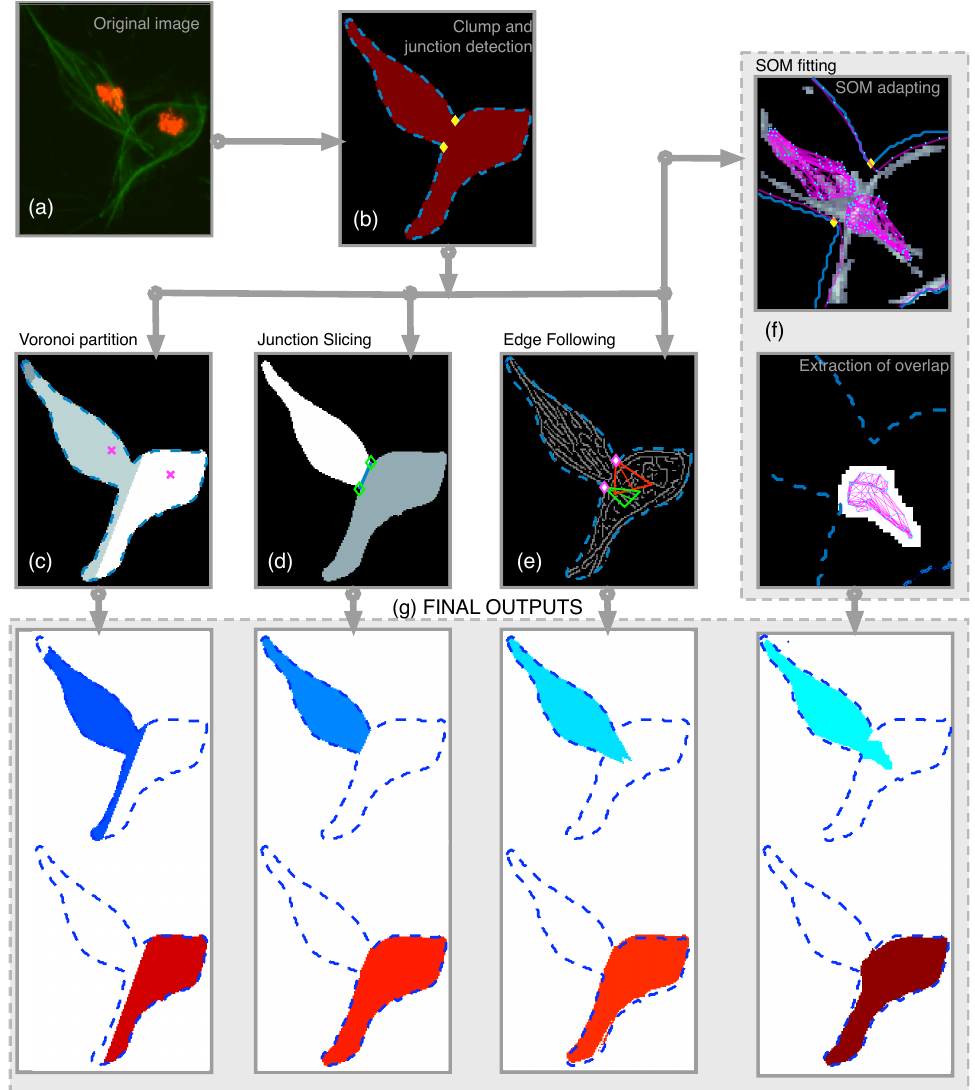
Figure 8. Illustration of all the methods developed and the workflow to obtain results. ( a ) shows the detail of CLUMP 2 in the original frame. Clumps are detected and the boundary was extracted. With the boundary information, the anglegram was calculated and the junctions were detected ( b ). On the second row, a diagram to the methods were presented. From left to right, the ( c ) Voronoi partition, ( d ) Junction Slicing (JS), ( e ) Edge Following (EF) and ( f ) SOM fitting. In ( g ) the outputs from each method for both cells within the detected clump are shown. [17] Reproduced with